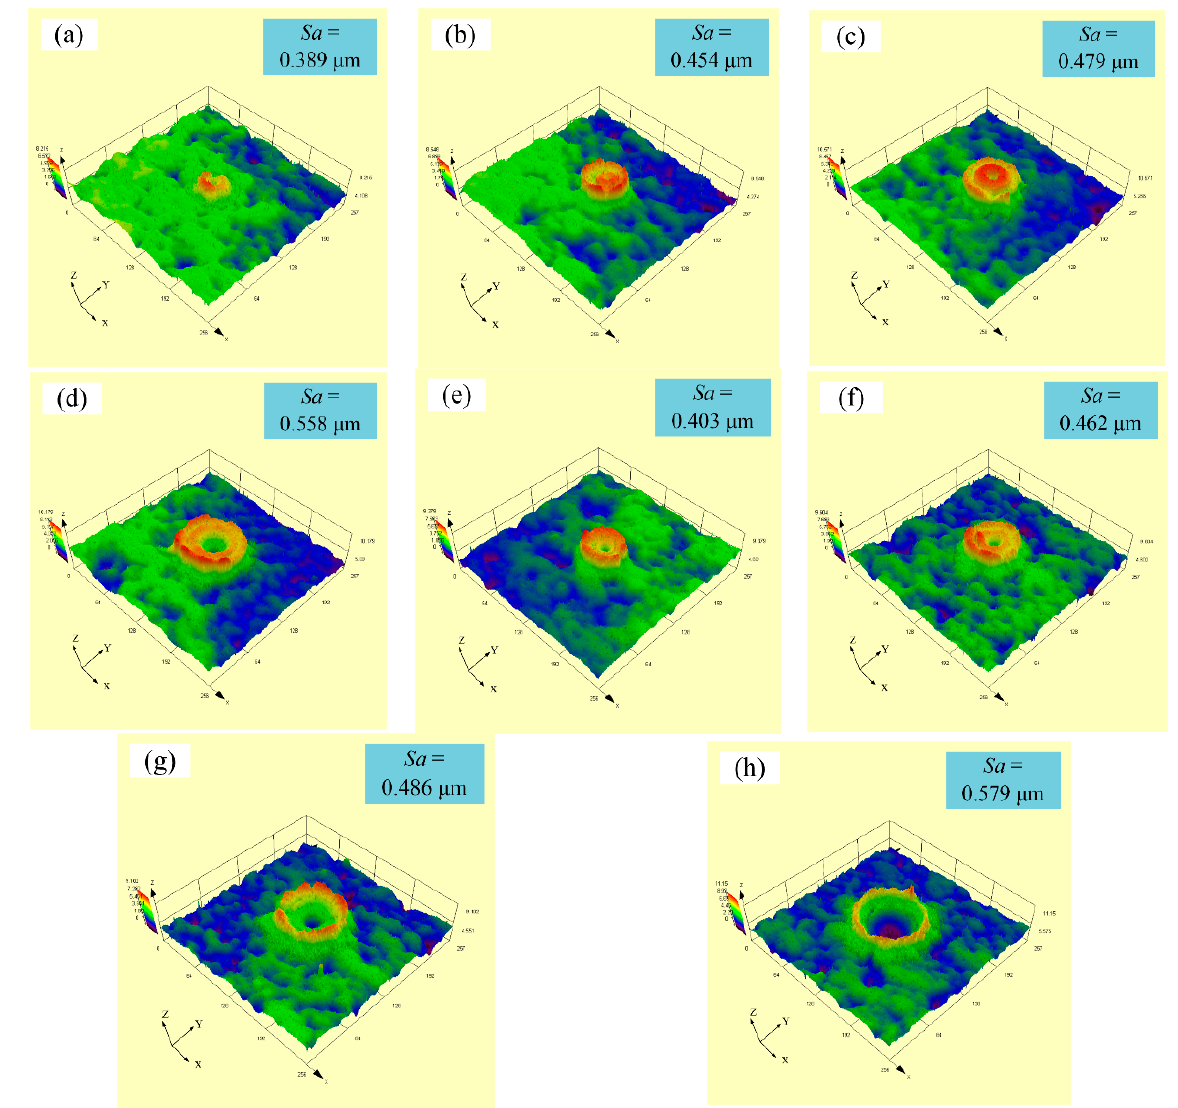
Figure 10. Experimental three-dimensional images with varying pulse width: ( a ) 75 µs, 50 W; ( b ) 100 µs, 50 W; ( c ) 125 µs, 50 W; ( d ) 150 µs, 50 W; ( e ) 75 µs, 60 W; ( f ) 100 µs, 60 W; ( g ) 125 µs, 60 W; ( h ) 150 µs, 60 W.